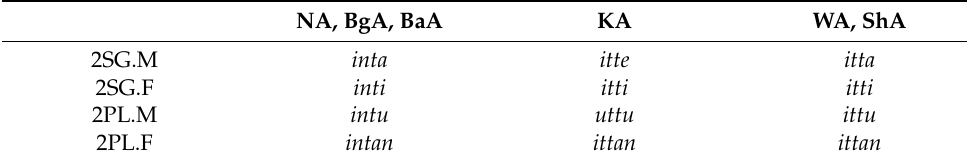
Table 1. 2nd person independent pronouns.